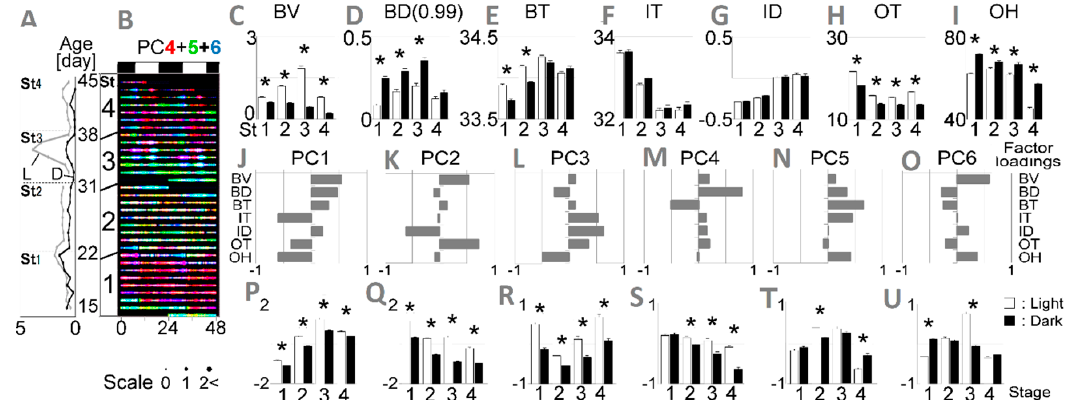
Figure 2. Developmental shift of circadian rhythm in three biological (B-) and four environmental (I-, O-) indices averaged in four infants and in terms of principal component scores. ( A ) Biological locomotion velocity (BV) trend lines compared between light (L) and dark (D) phases from age stage St1 to St4; ( B ) 30-min-raster plots (48 h horizontally versus postnatal day vertically) with a size marker at the bottom; overlaid raster plot of principal components PC4 (red), PC5 (green) and PC6 (blue). In C-I; Light-dark statistical comparison per age stage for each variable. Error bars indicate standard error of the mean (s.e.m.) * p < 0.05 by Tukey’s honestly significant difference (HSD) test following two-way analysis of variance (ANOVA); ( C ) biological locomotion velocity (BV); ( D ) place preference toward the door (BD) more than 99% (BD (0.99)); ( E ) body surface temperature (BT); ( F ) indoor temperature (IT); ( G ) indoor temperature gradient toward door (ID); ( H ) outdoor temperature (OT); ( I ) outdoor humidity (OH); ( J – O ) seven factor loadings of PC1–PC6. In ( P – U ) light-dark statistical comparison per age stage for PC1–PC6. Error bars indicate s.e.m. * p < 0.05 by Tukey’s HSD test following two-way ANOVA.